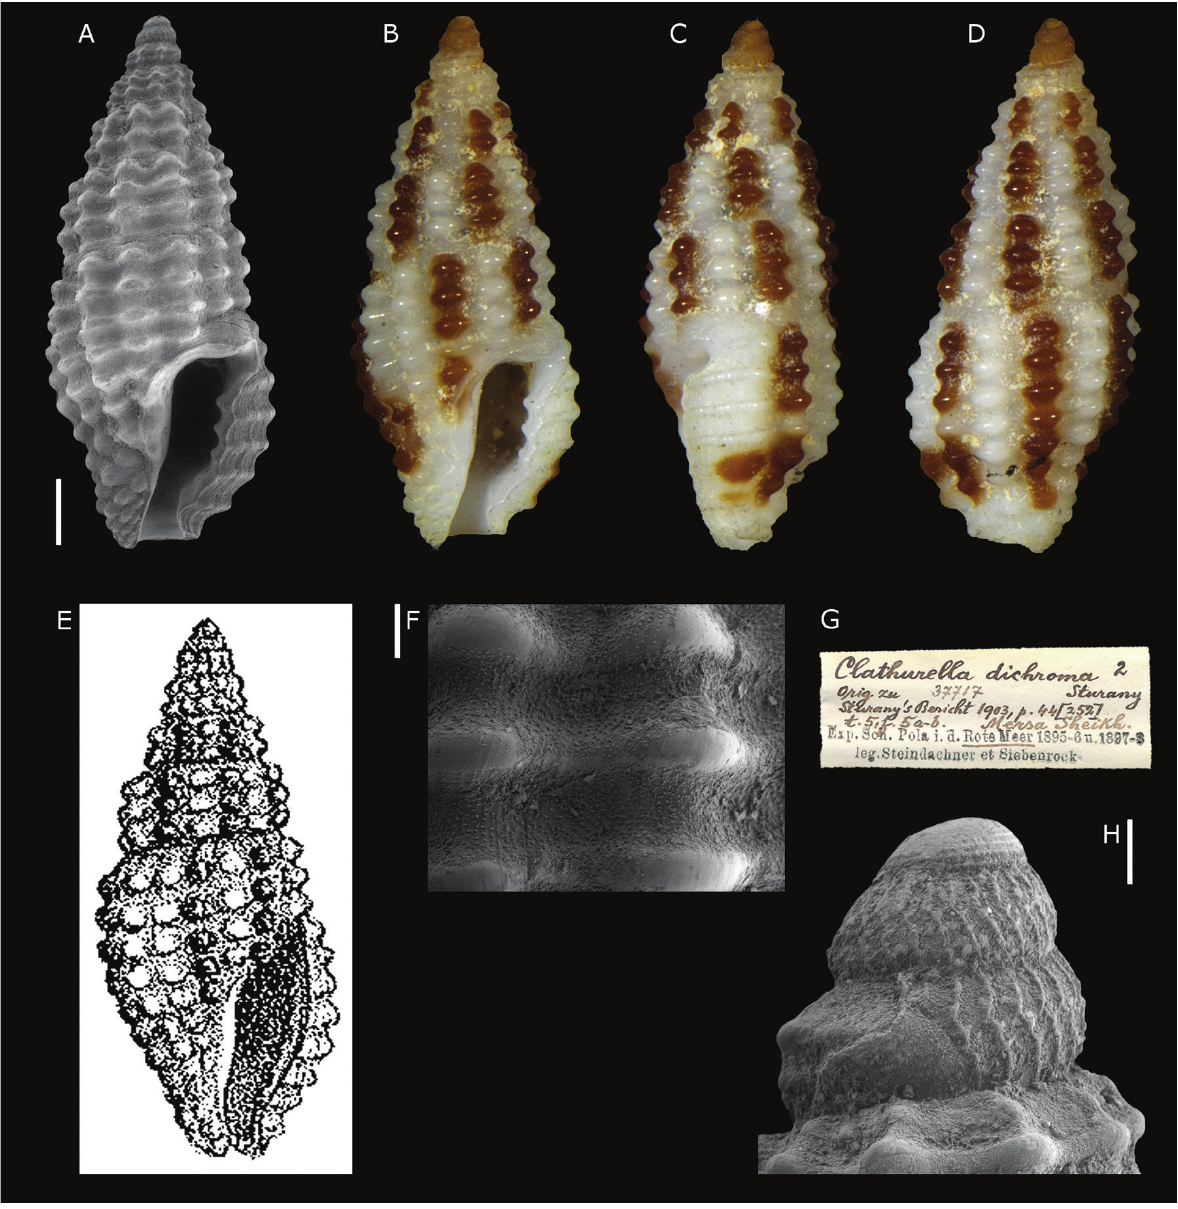
Figure 29. Clathurella dichroma Sturany, 1903, Locality 25 (Abu Ghusun, Egypt, Red Sea). A–D , F , H . Figured syntype, NHMW 37717: front ( A–B ), right side ( C ), back ( D ), microsculpture ( F ), protoconch ( H ). E . Original figure by Sturany (1903). G . Original label. Scale bars: A–D : 0.5 mm, F , H : 0.1